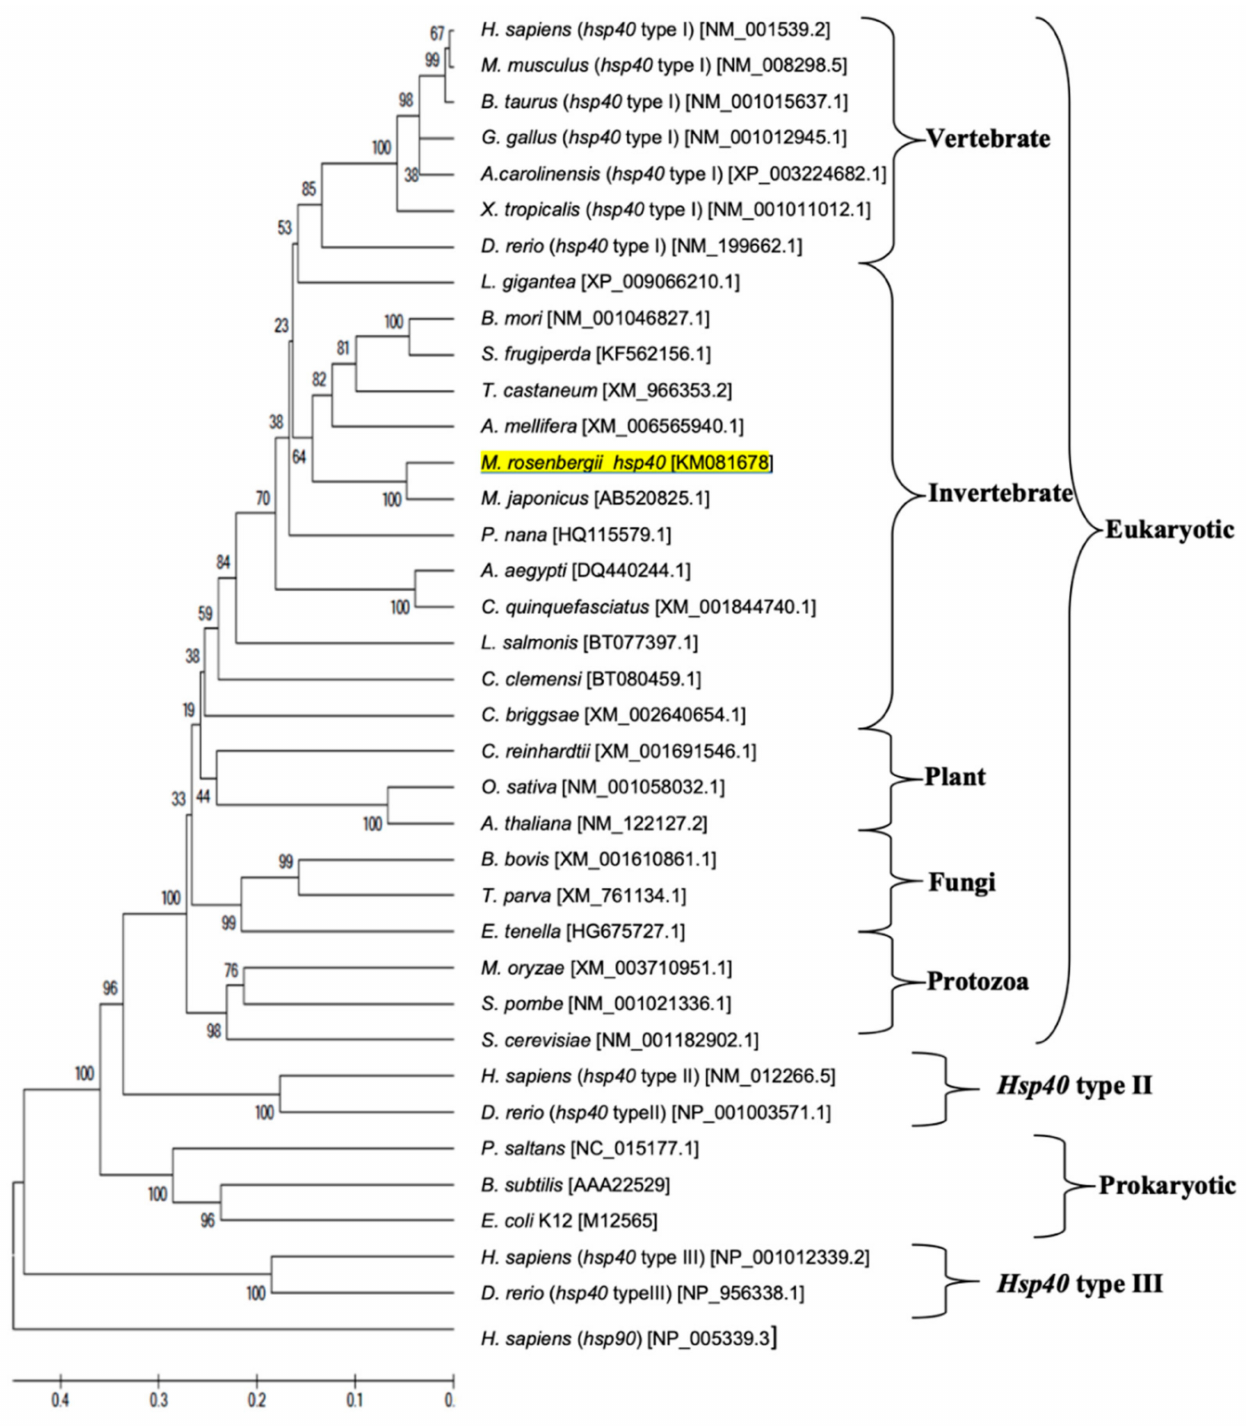
Figure 5. Phylogenetic tree showing the relationship of the Hsp40 gene of the Macrobrachium rosenbergii amino acid sequence with those of other known species produced using the neighbor-joining method. Sequences used in the tree, followed by their GenBank accession number, are shown in Supplementary Material Table S1. Mr-hsp40 is